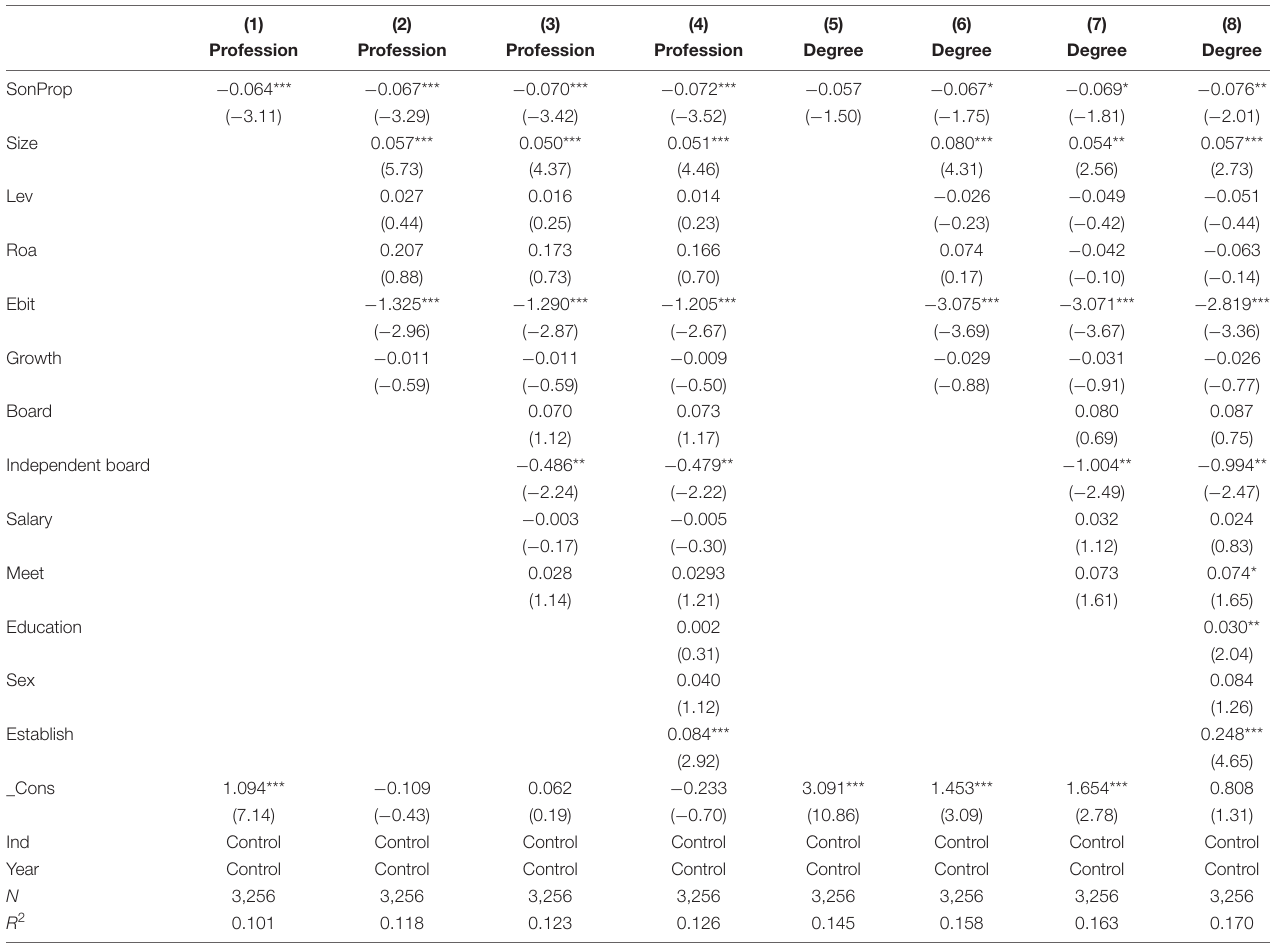
TABLE 7 | Change in the sample size: the proportion of sons of actual controllers and professional